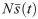
Longer sampling: Bistability.(A) Evolution of the total activity Ns¯(t) produced by Glauber dynamics, as in Fig 2A, but with 5 × 107 steps. The dashed grey line marks the end of the previous shorter sampling of Fig 2A. (B) Evolutions of the total-population activity Ns¯(t) obtained from several instances of Glauber dynamics. Each instance starts with a different value of the initial total activity Ns¯(0), i.e. with Ns¯(0) initially active neurons (chosen at random), and is represented by a different red shade, from Ns¯(0)=0 (light red) to Ns¯(0)=N (dark red). Note the two convergence basins, one at Ns¯≈100 and one at Ns¯≈15. (C, D) New values of the time averages mi and gij versus the experimental ones. These new values are obtained from the longer Glauber dynamics described in (A) using the values of the Lagrange multipliers hi^,Jij^ shown in Fig 2D, obtained from the previous Boltzmann learning. The plots clearly show that the values of hi^,Jij^ found with the Boltzmann learning are not the ones yielding the constraints mi, gij.